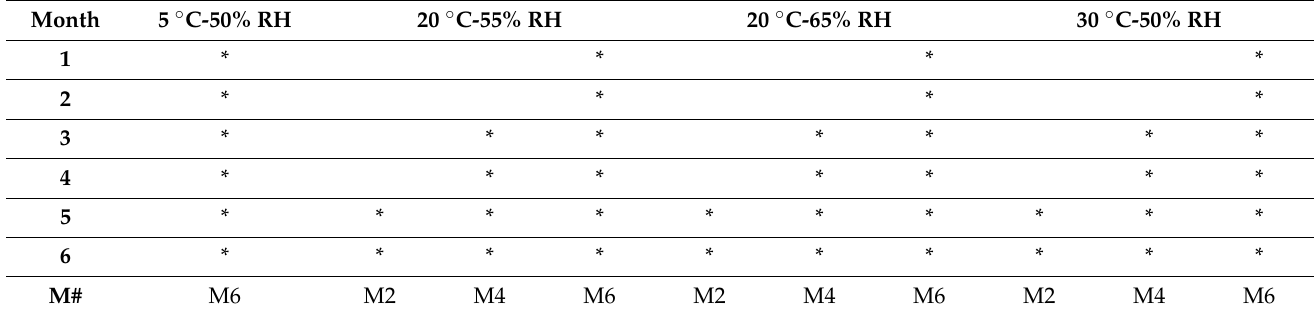
Table 1. Conditions and duration of pasta storage trial (reverse